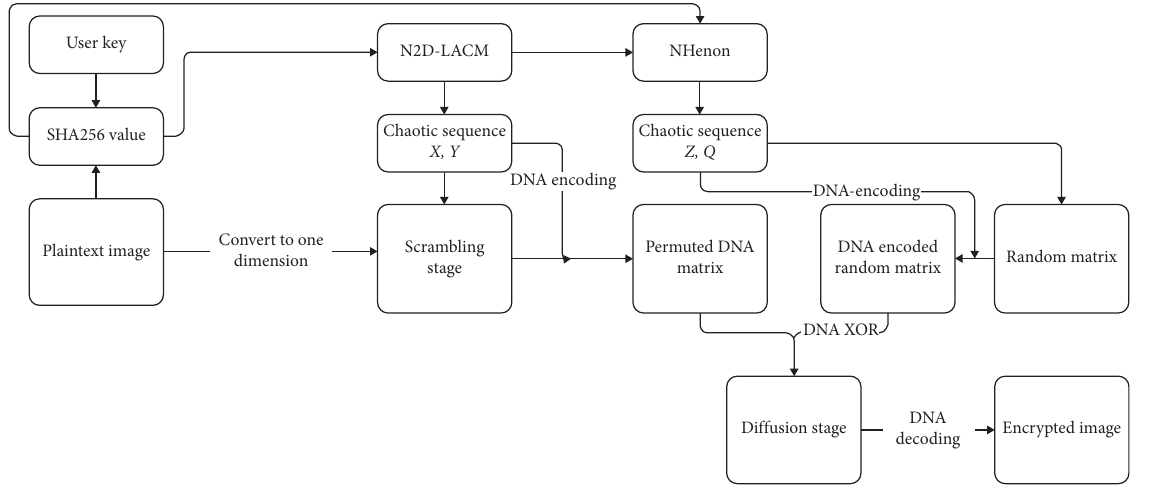
Figure 9: Encryption algorithm flow